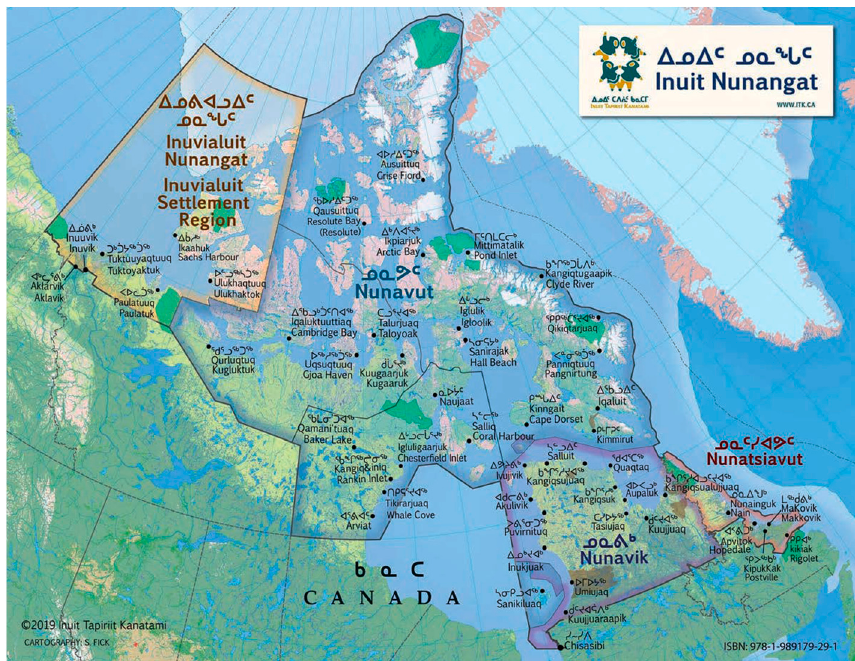
Figure 1. Map of Inuit